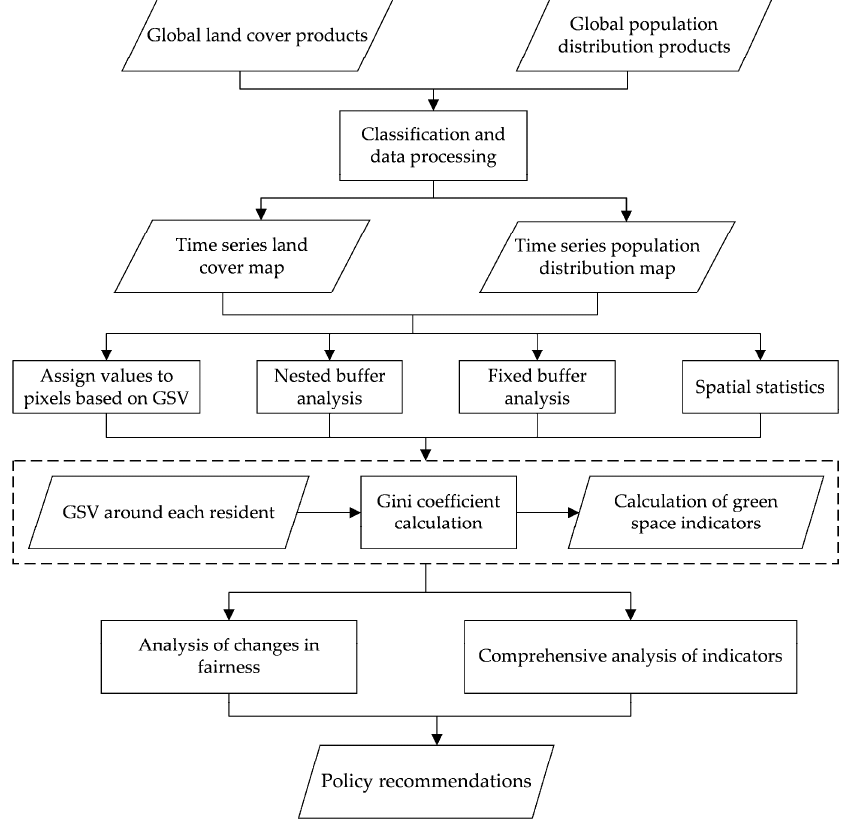
Figure 1. The research